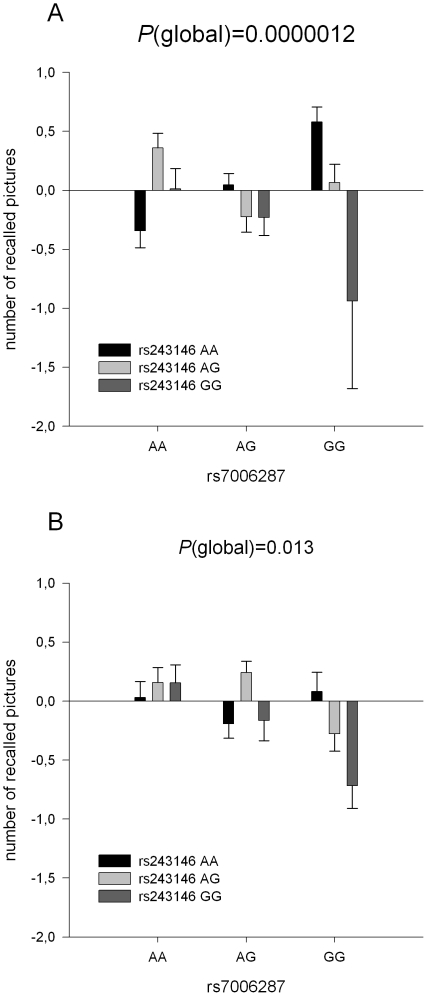
Number of recalled pictures (z-transformed means and standard error of the mean) as a function of rs243146 (A/G) genotype and rs7006287 (A/G) genotype (A) in the screening sample (B) in the replication sample.